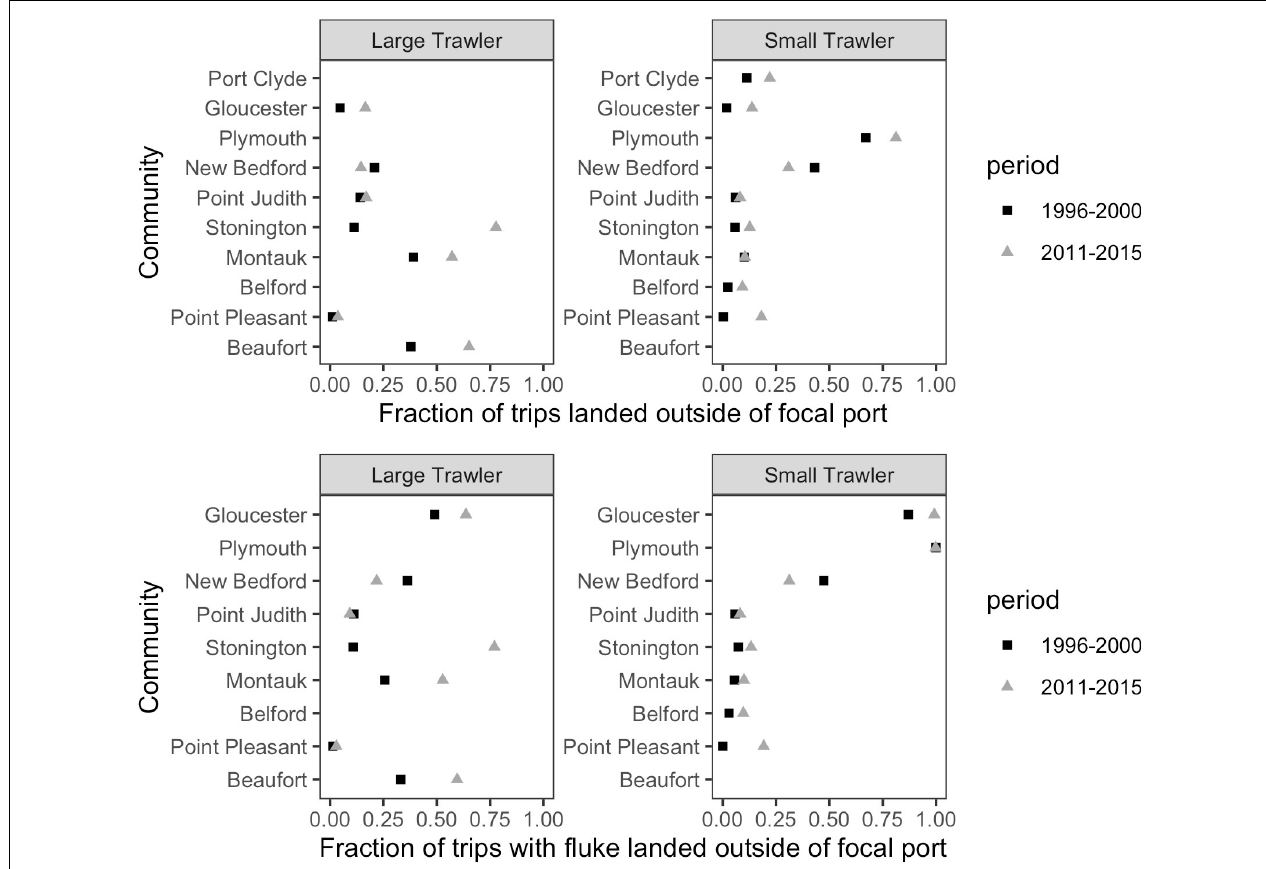
FIGURE 12 | For vessels associated with a port as a declared port or a principal port of landing, the fraction of trips landed outside of the focal port for (top) all species and (bottom) only trips that landed fluke. This represents the degree to which a port “sends” trips to other